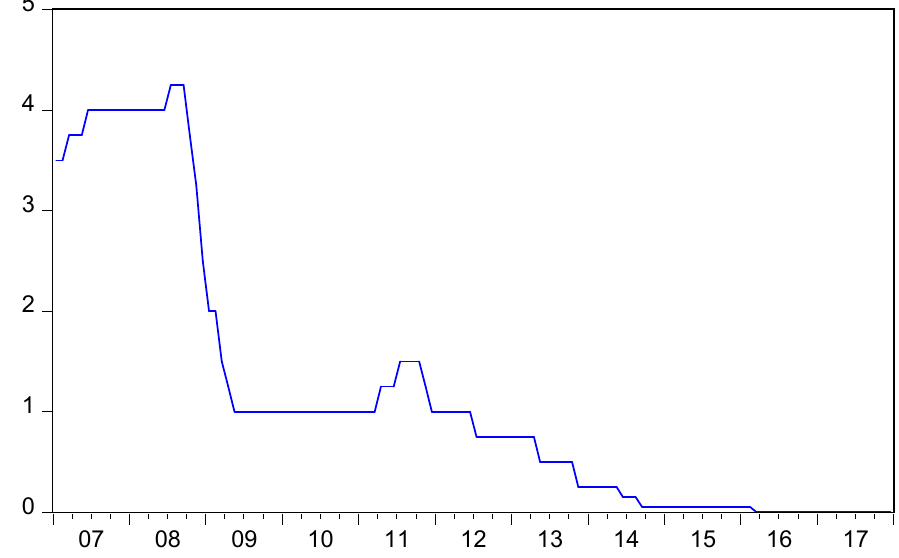
Figure 1. ECB’s interest rate of main refinancing operations, in percentages per annum. Source: ECB statistical data warehouse.